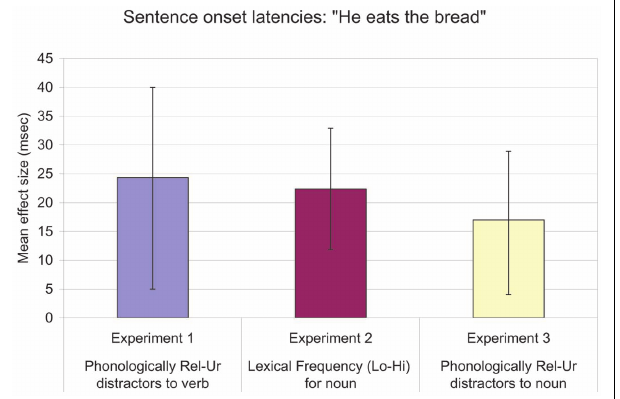
FIGURE 1 | Experiments 1–3 sentence onset difference scores and 95% confidence intervals. Experiment 1 distractors phonologically related (rel) and unrelated (ur) to the verb were displayed. Experiment 2 sentences produced with either low (lo) or high (hi) frequency objects. Experiment 3 distractors phonologically related and unrelated to the noun were